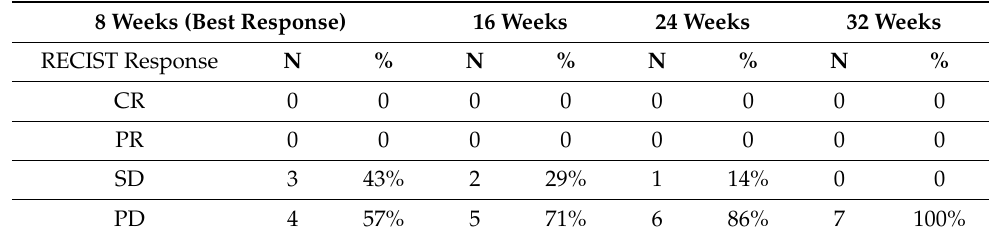
Table 2. Best overall response rate in the evaluable population n = 7 at 8 weeks and ORR at 16, 24 and 32 weeks.